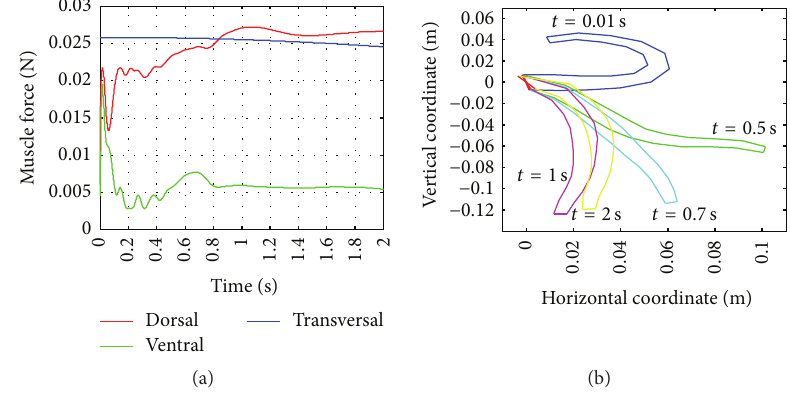
Figure 4: Muscles forces of the first octopus arm segment and a sequence of octopus arm movements: (a) muscles forces of the first segment and (b) a sequence of octopus arm